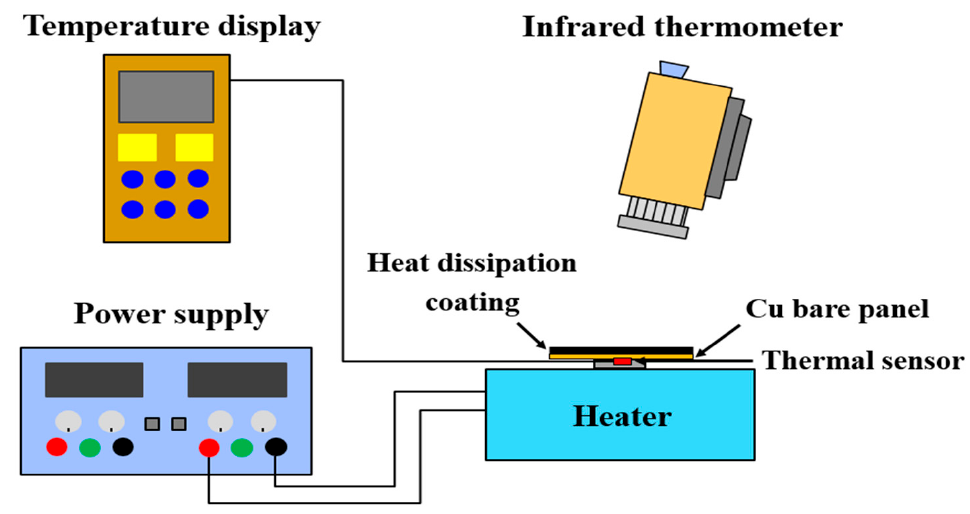
Figure 4. Schematic of the temperature monitoring system and thermal emissivity measurement.